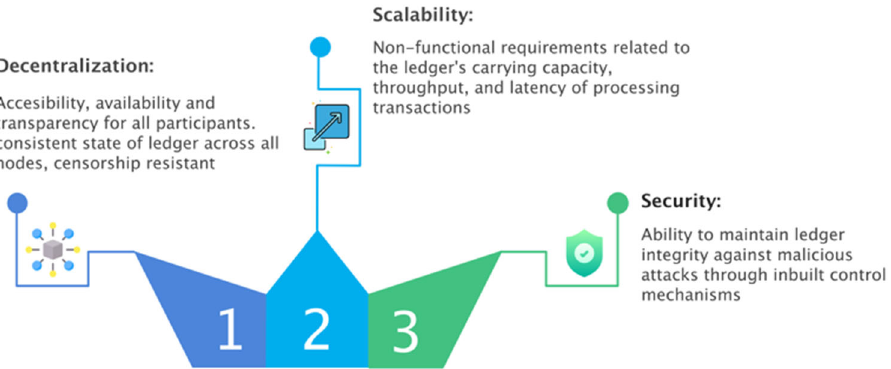
Figure 4. Blockchain Implications .